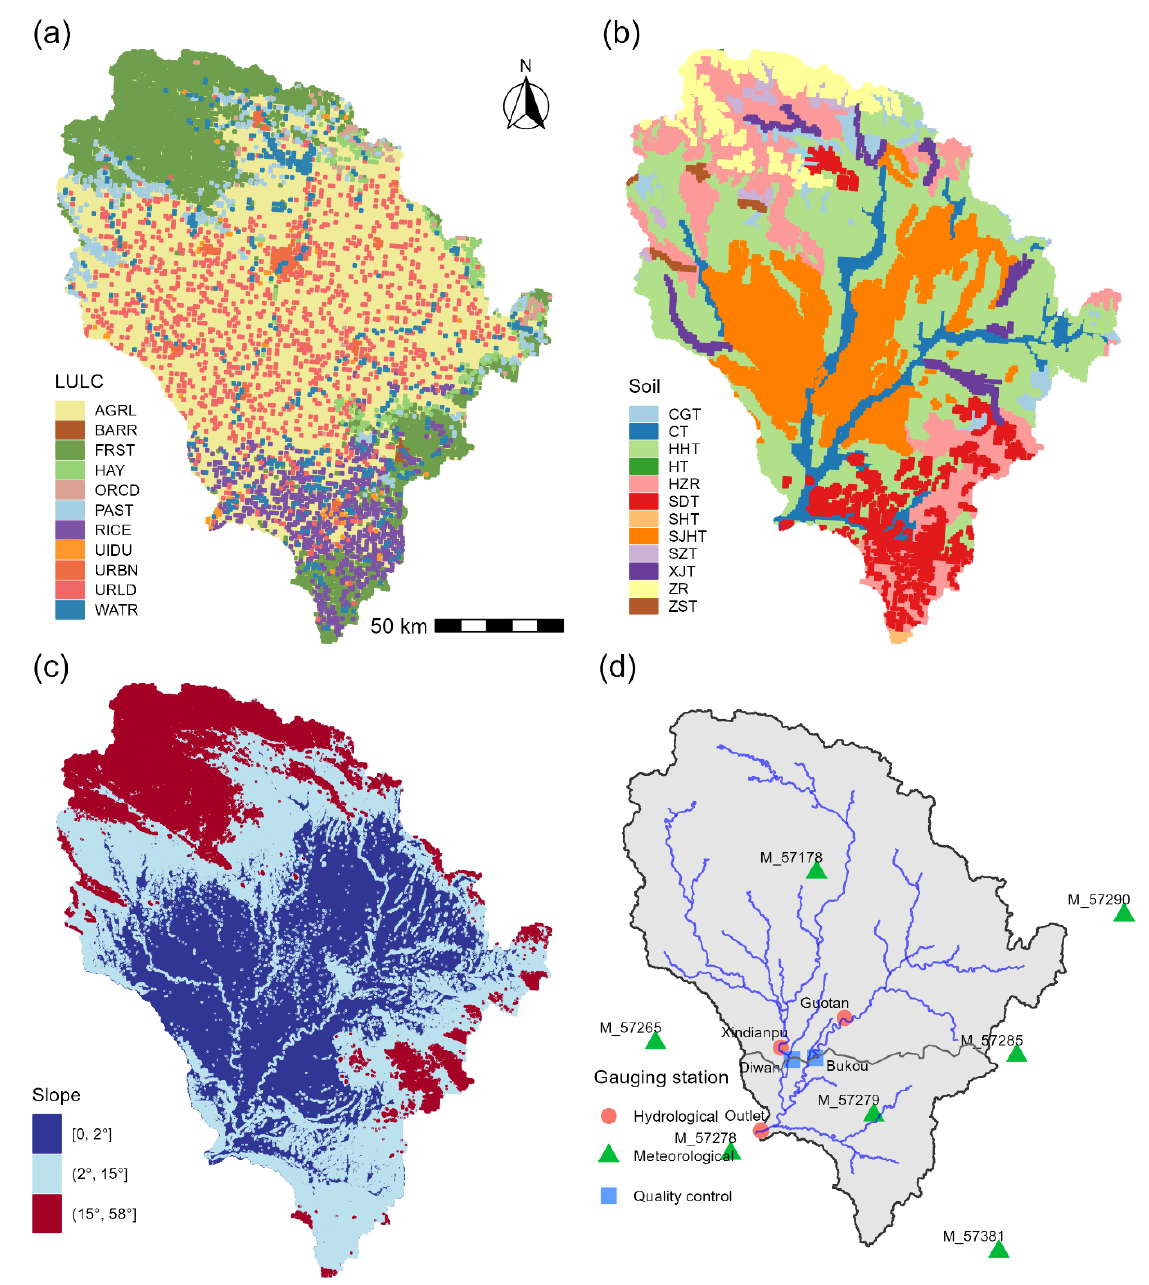
Figure 2. The spatial distribution of the land ‐ use/land ‐ cover (LULC) classes in 2015 ( a ), soil types ( b ), slope classes ( c ), and ( d ) gauging stations in the SWAT ‐ generated stream network, distinguishing meteorological stations used for building SWAT (triangle), hydrological stations used for model validation (circle), and water quality monitoring sections at the provincial boundary (square). Abbreviations of land ‐ cover classes and soil types are found in the main text.